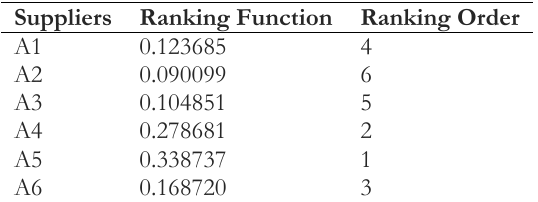
Table 9. Final aggregation of experts’ preferences for each